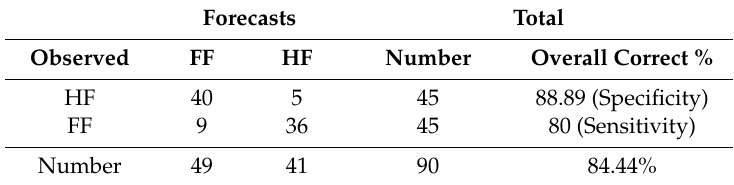
Table 9. Classification of failing firms (FF) and healthy firms (HF) one year earlier.